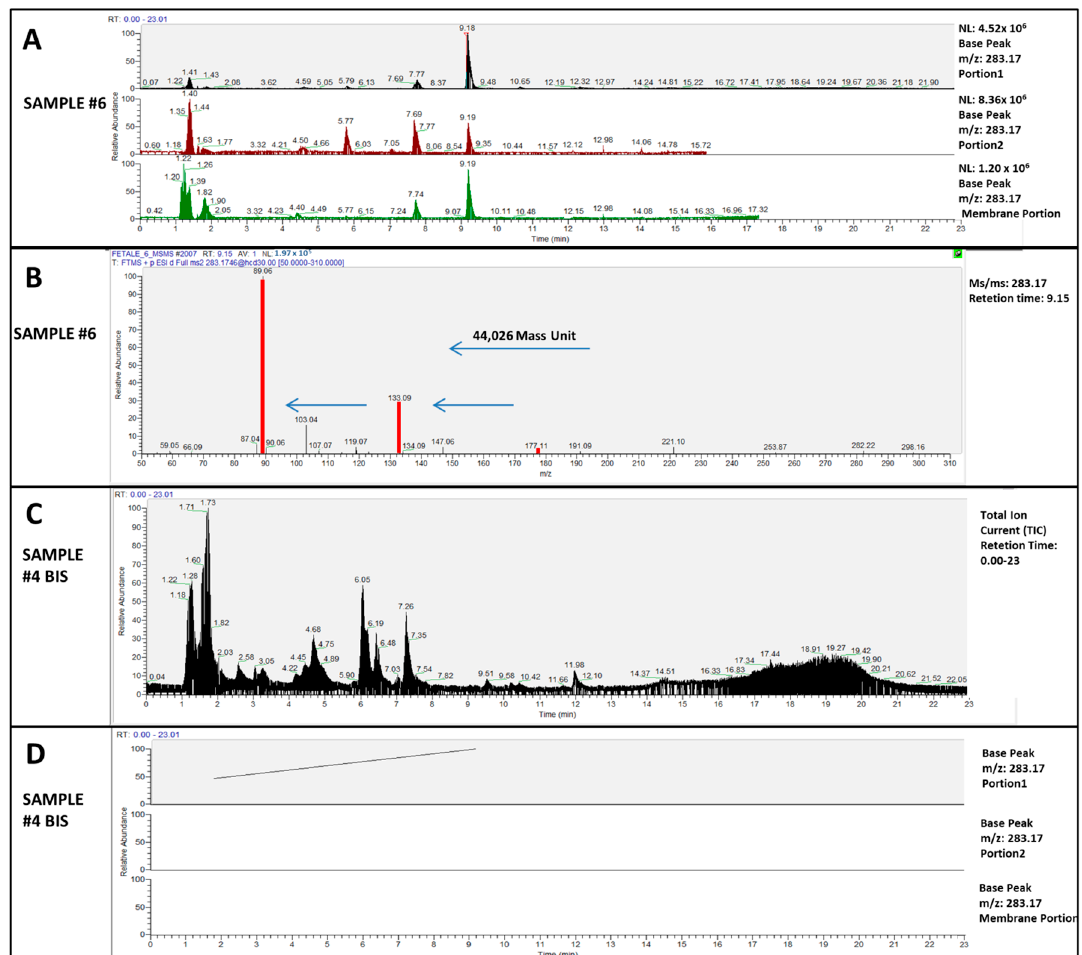
Figure 1. ( A ): Base peak chromatogram at RT 9.15 min of 283.17 m / z of all portions collected from sample #6. ( B ): A MS/MS spectrum showing the differences in mass of the polyethylene glycol series (44.0262 mass units). ( C ): Total ion current (TIC), of Placenta #4bis considered control samples. ( D ): Base peak chromatogram of 283.17 m / z of three portions collected from sample Placenta #4bis. The base peak chromatogram does not report any peaks corresponding to 283.17 m / z . Table 1. Identification of different masses of ethylene oxidative with 4 monomers to 10 monomers (EO-4 to EO-10) of PEGs in portion 1 and portion 2 from the placenta and the membrane portion. The symbol “*” represents the presence of the PEG fragment in the sample.